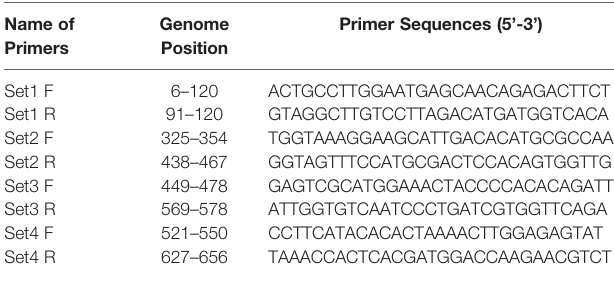
TABLE 1 | Details of Env gene speci fi c oligonucleotide primers used for basic reverse transcription recombinase polymerase ampli fi cation (RT-RPA) assay.